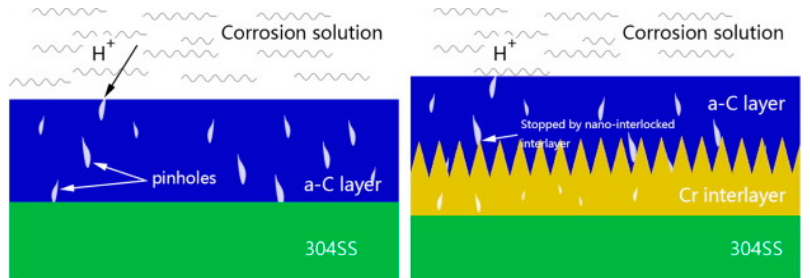
Figure 9. Principle of Cr-interlayer effect for amorphous carbon coating. Reprinted from [26] copyright (2016), with permission from Elsevier.